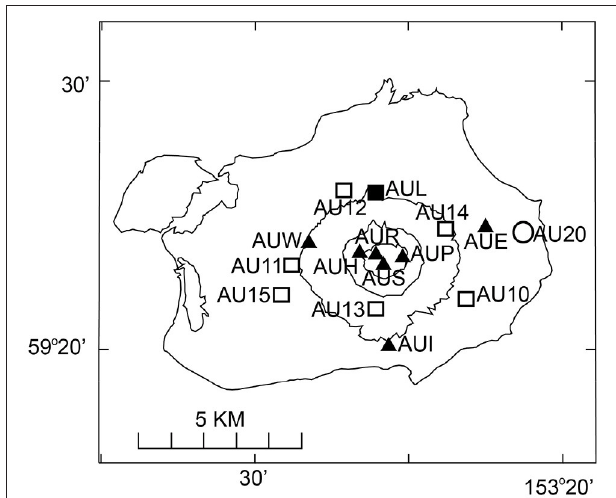
FIGURE 5 | Map showing the location of seismic stations on Augustine Volcano in 2006 from Power and Lalla (2010). Solid triangles represent short-period stations, the solid square is a permanent broadband station at AUL, open squares represent temporary broadband stations, and the circle is a strong motion instrument at AU20.